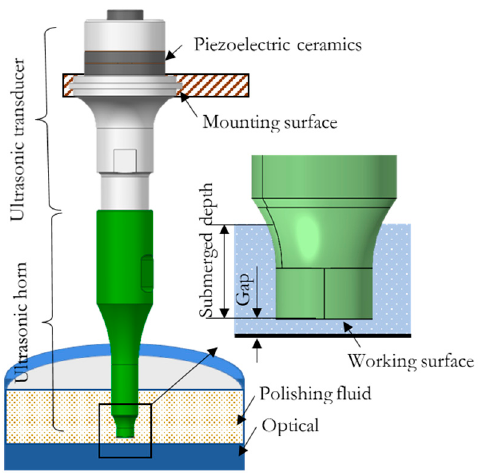
Figure 1. A schematic of non − contact ultrasonic abrasive machining